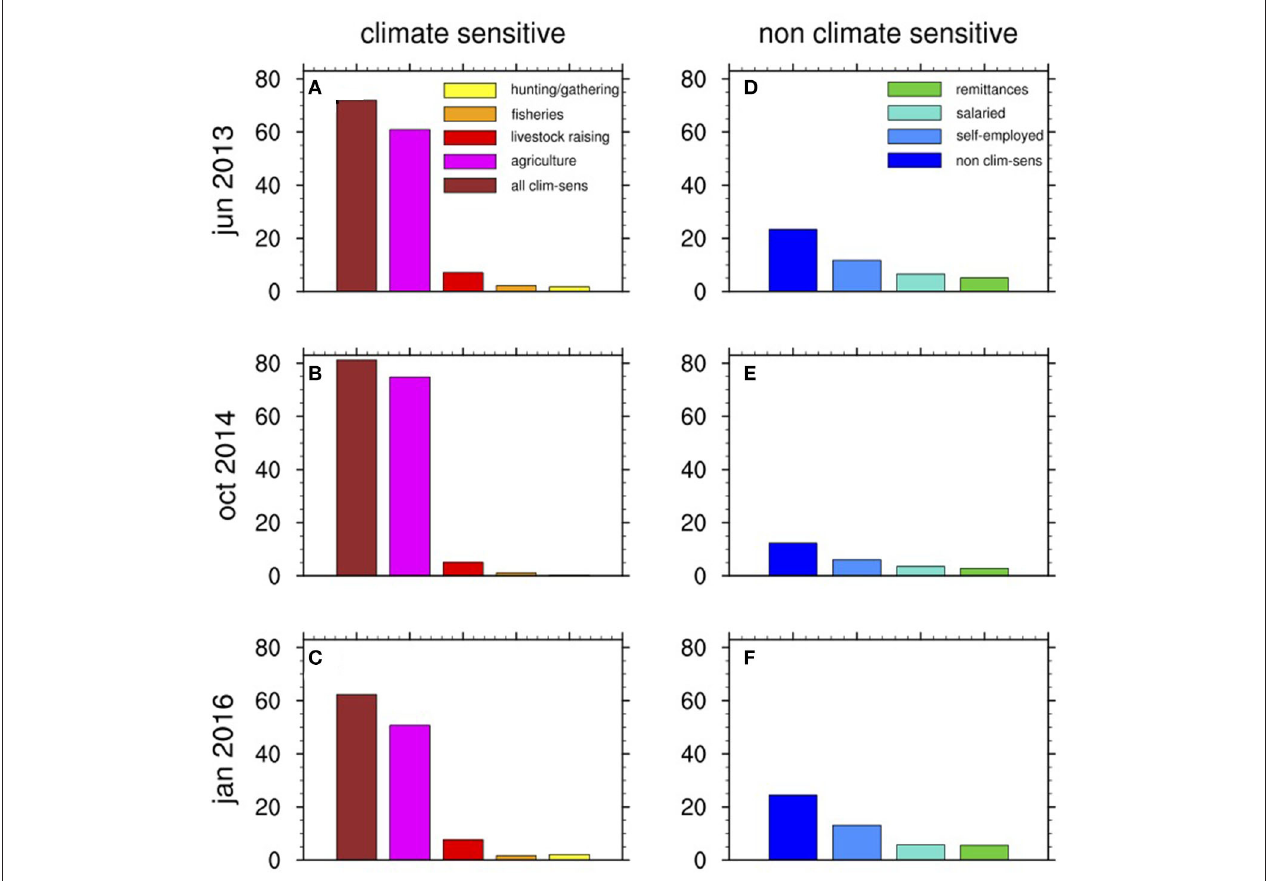
FIGURE 6 | Dominant source of income, or economic activity that the household engages in. Panels on the left (A–C) depict the percent of households engaged in climate-sensitive activities, panels on the right (D–F) , those engaged in non-climate sensitive activities Each row is a survey: (A,D) correspond to 2013, (B,E) to 2014, and (C,F) to 2016. The leftmost bar in each panel (dark red in A–C , dark blue in D–F ) is the sum of all the other bars in the same